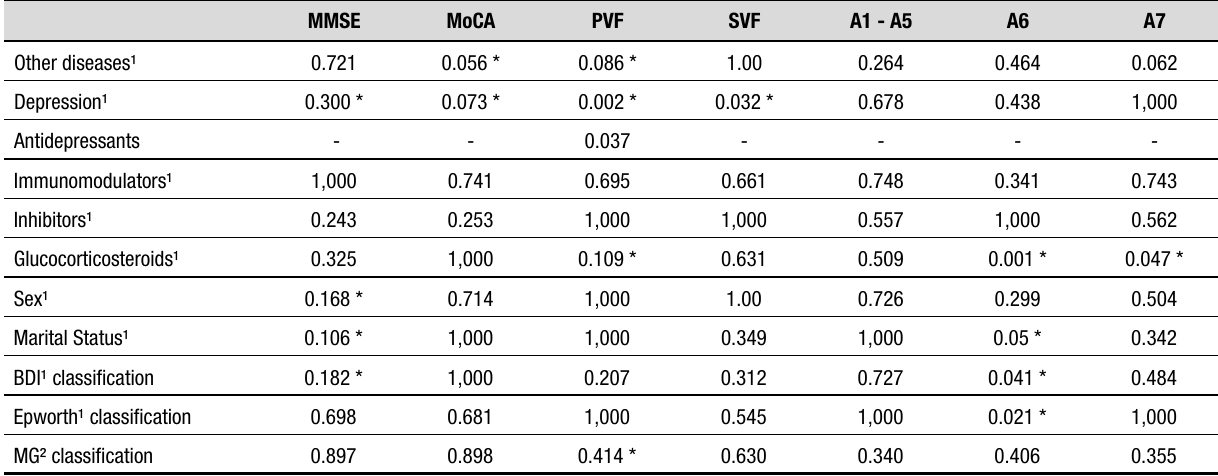
Table 4. Association between cognitive tests and contextual